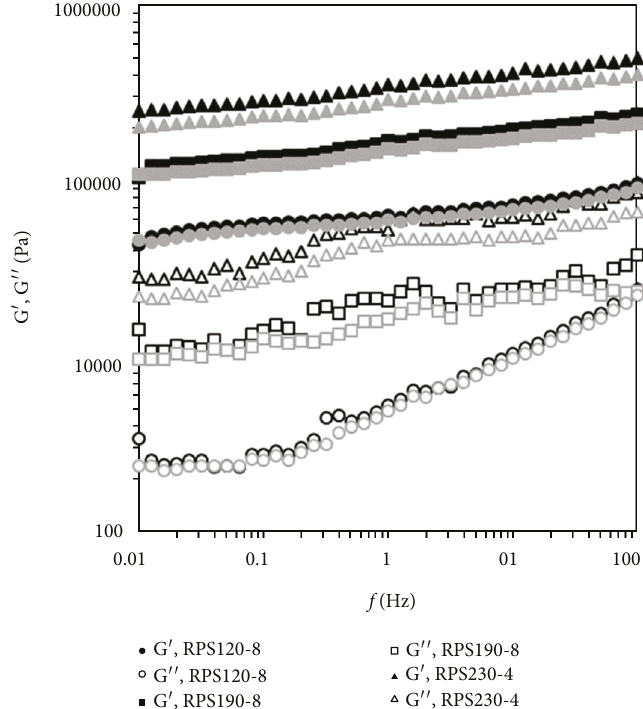
Figure 3: Mechanical spectra at 25 ° C of selected gels prepared from RPS120-8, RPS190-8, and RPS230-4. Note here that grey symbols correspond with the mechanical spectra data collected from the second heating/cooling